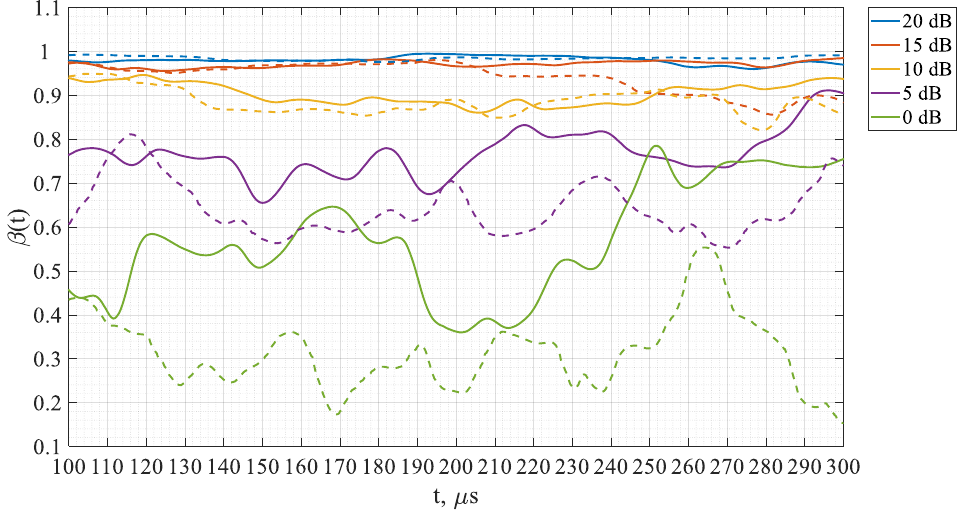
Figure 6. Hardware (solid lines) and simulation (dashed lines)-based results for the experimental study of the noise immunity of the RC1 chaos oscillator’s synchronization.